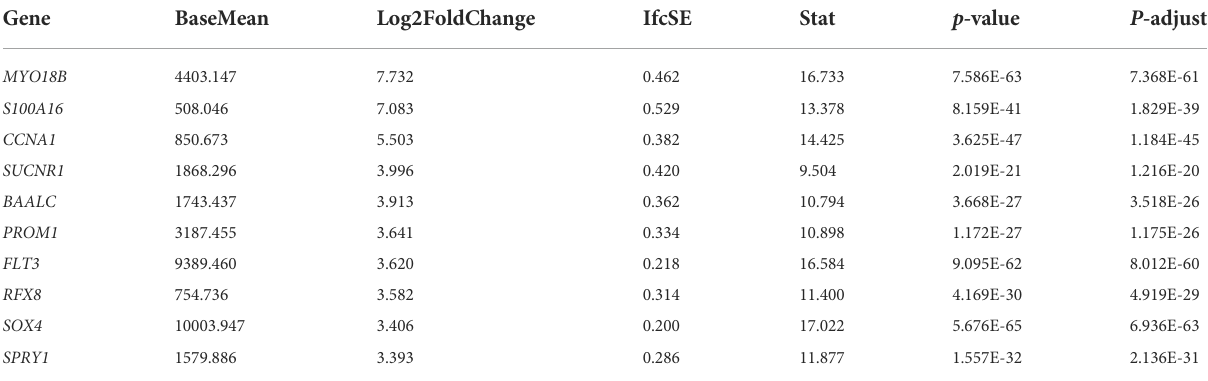
TABLE 2 The top 10 up-regulated genes.